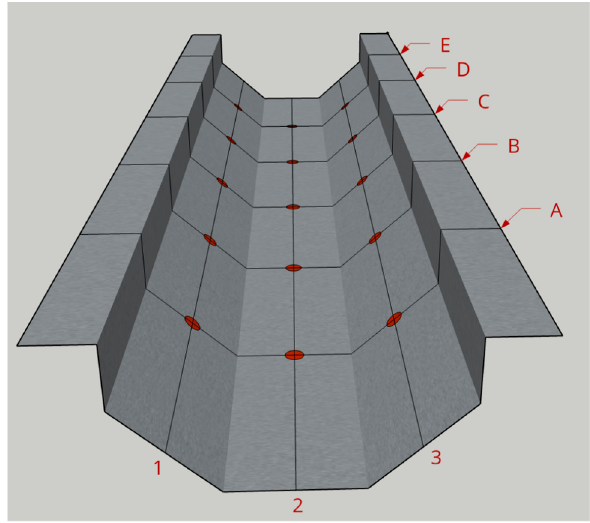
Figure 3. Mesh of measurement